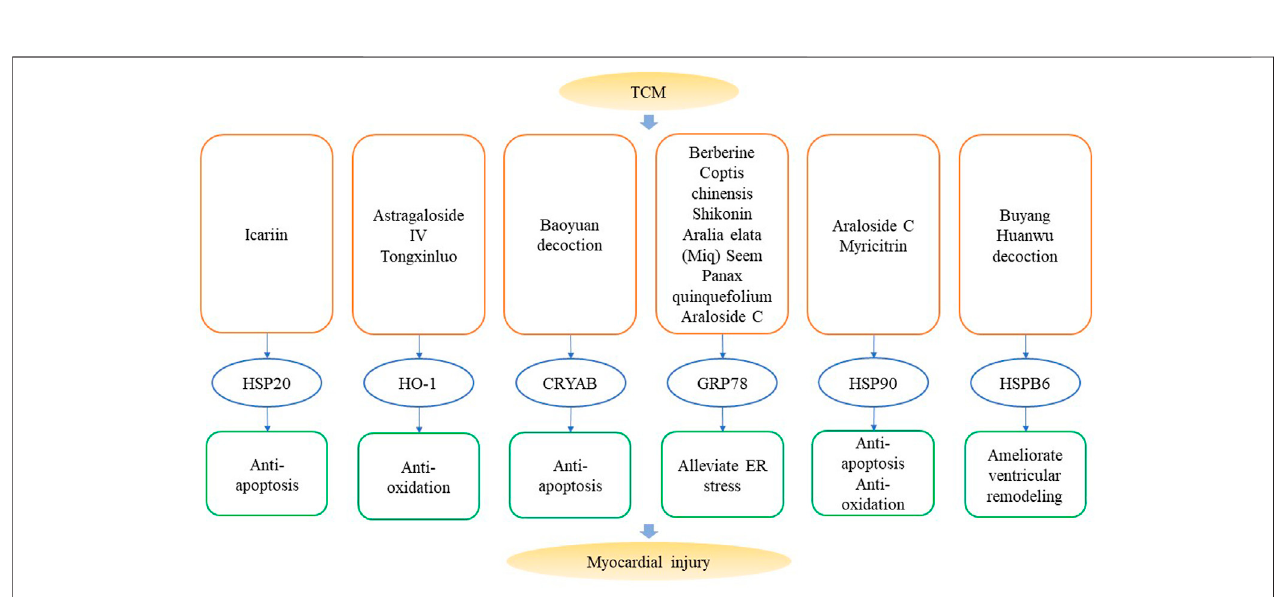
FIGURE3| Traditional ChineseMedicinethattargetheatshockproteinsinmyocardialinjuries.Componentslikeicariin,astragalosideIV,berberineanddecoctions like Baoyuan decoction and Buying Huanwu decoction can alleviate myocardial injury via anti-apoptosis, anti-oxidation, reducing ER stress and cardiac remodeling by regulating the expression of